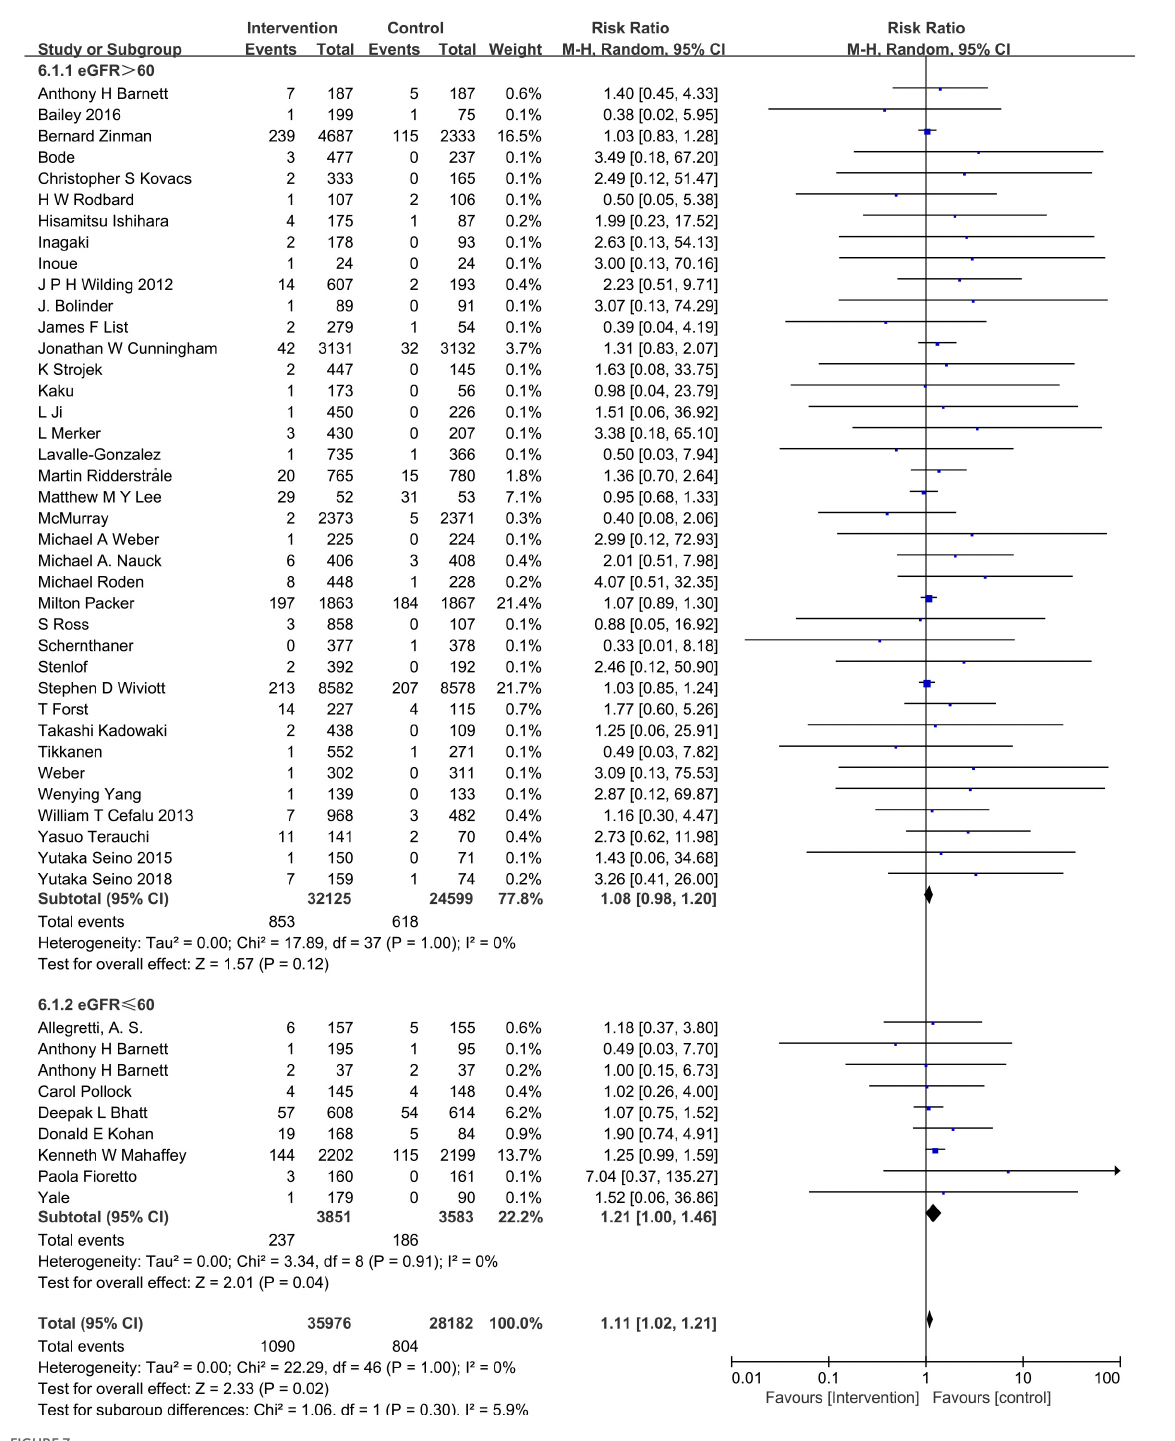
FIGURE7 Subgroup analysis of the hypovolemia events between the SGLT2 inhibitors group vs. the placebo group stratified by eGFRs.